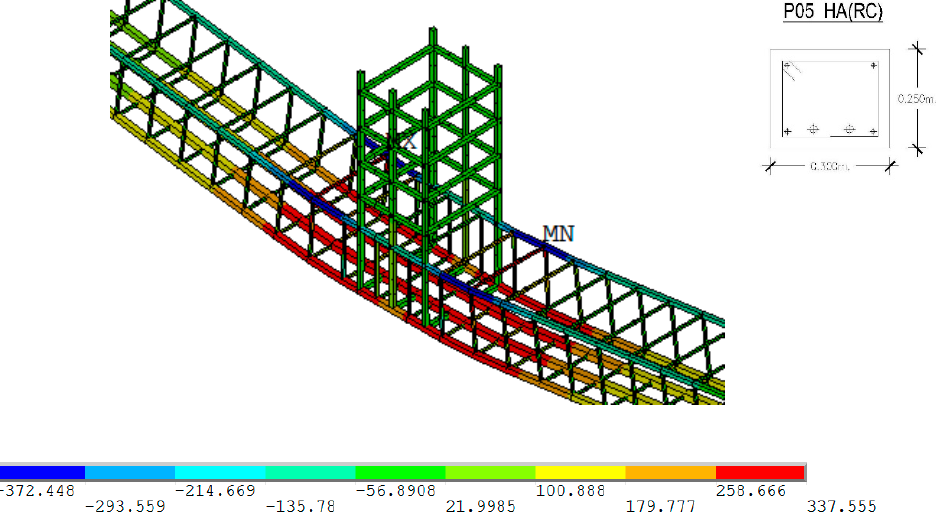
Figure 26. Stress in steel bars of prototype P05 simulated for a 200 mm deflection.